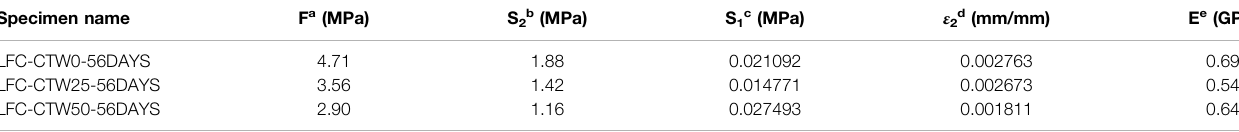
TABLE 8 | Modulus of elasticity of LFC-CTW0, LFC-CTW25, and LFC-CTW50 for 56 days.